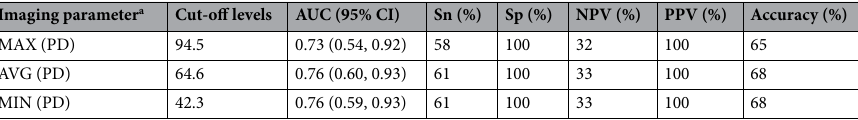
Table 2. Use of CTUS imaging in identifying RA patients with DAS28 > 3.2 applying ROC analysis. AUC, area under the ROC curves; Sn, sensitivity; Sp, specificity; NPV, negative predictive value; PPV, positive predictive value. a MAX (PD), AVG (PD) and MIN (PD) are combined thermal and ultrasound imaging results derived by multiplying MAX, AVG and MIN by a factor of 2 when a patient’s total ultrasound power Doppler joint inflammation score exceeds the median score. Otherwise, MAX (PD), AVG (PD) and MIN (PD), remained unchanged from the MAX, AVG and